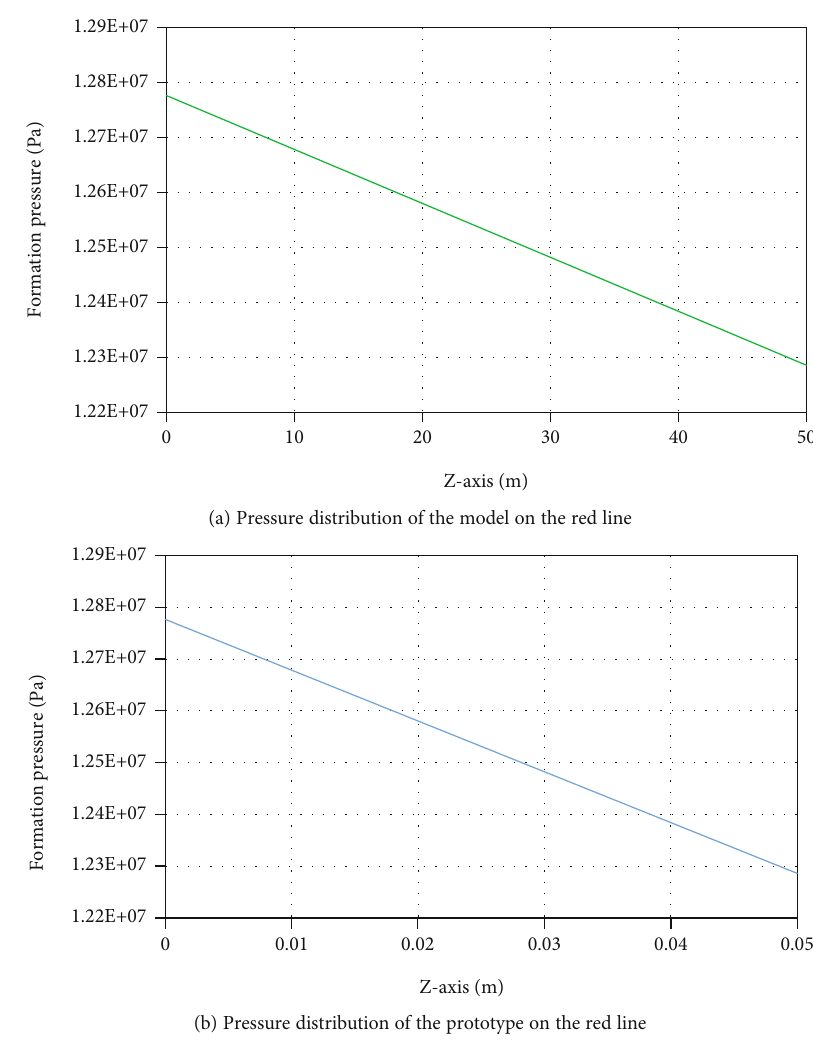
Figure 7: Pressure distributions of the prototype and the